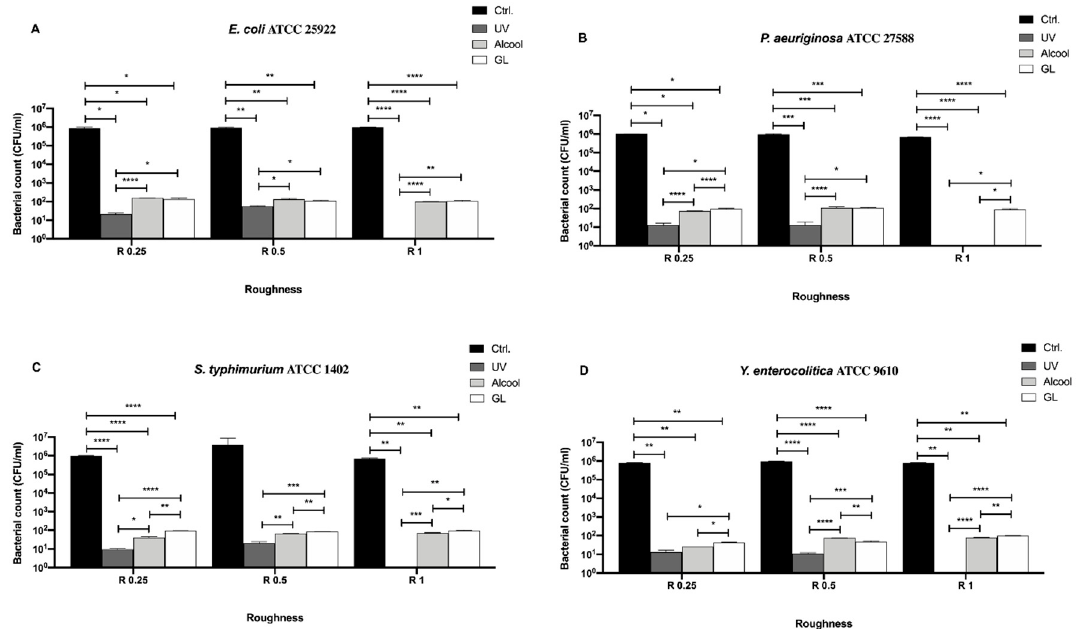
Figure 3. Antibacterial activity of UV, alcohol and GL against Gram-negative bacteria ( A ) E. coli ATCC 25922, ( B ) P. aeruginosa ATCC 27588, ( C ) S. typhimurium ATCC 1402 and ( D ) Y. enterocolitica ATCC 9610 at different surface roughness, **** p < 0.0001, *** p < 0.001, ** p < 0.01, * p < 0.05.